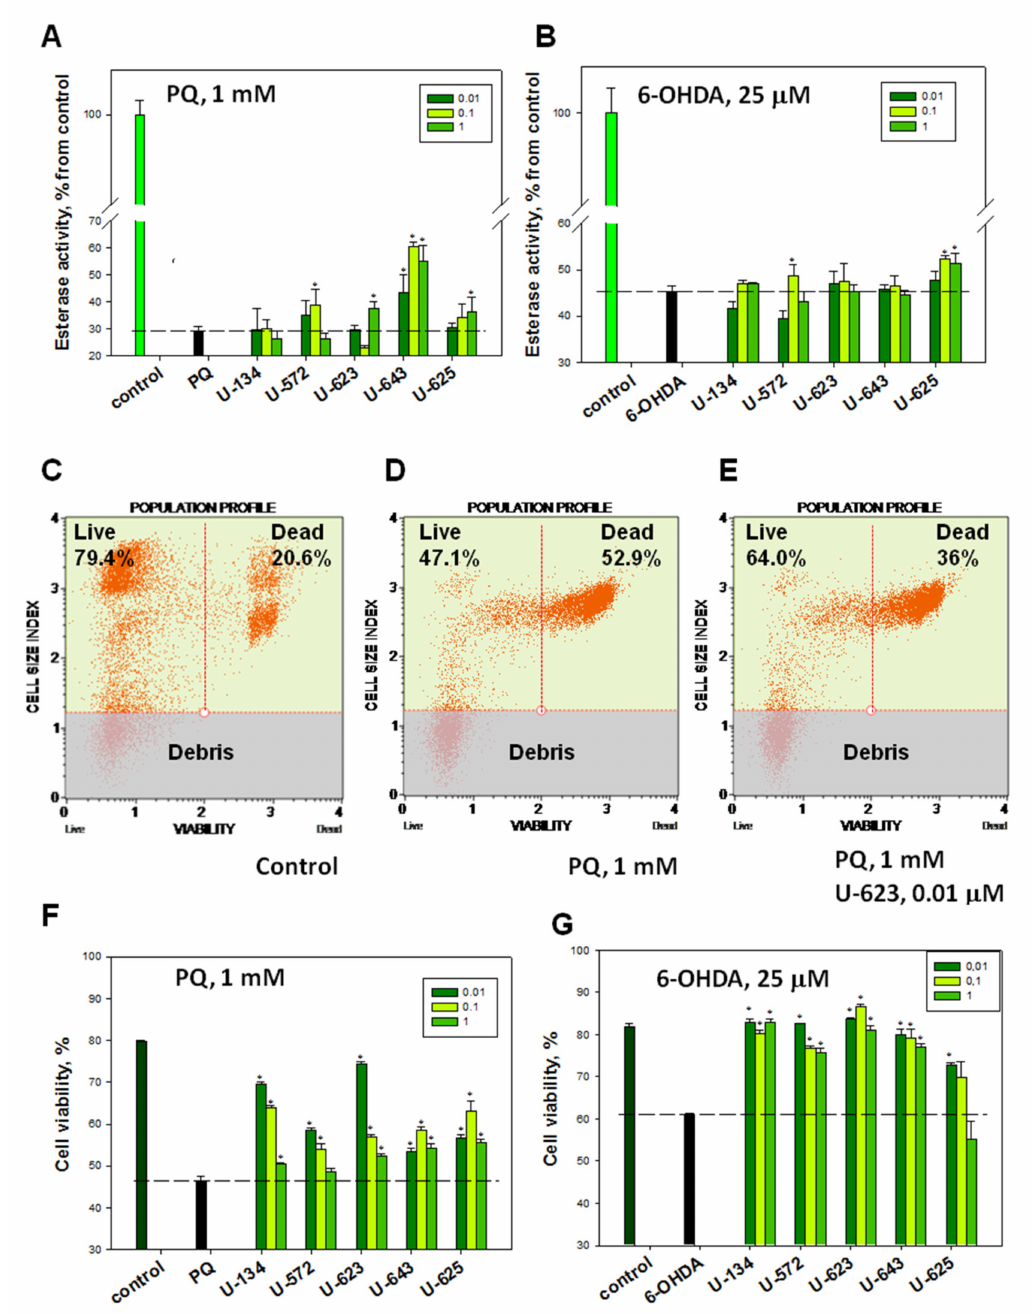
Figure 2. 1,4-NQs protect Neuro-2a cells against neurotoxicity induced by PQ and 6-OHDA. ( A , B ) determination of nonspecific esterase activity in cells incubated with PQ (1.0 mM, A ) or 6-OHDA (25.0 µ M, B ) using a FDA fluorescent probe and spectrofluorimetry. ( C – E ) count and viability assay. The figures show the percentage of live and dead cells determined using flow cytometry and PI staining: Control ( C ), PQ, 1.0 mM ( D ); PQ, 1.0 mM, and U-623 , 0.01 µ M ( E ). ( F , G ) determination of the viability of cells incubated with PQ ( F ) or 6-OHDA ( G ) using a PI fluorescent probe and fluorescent flow cytometry. Concentrations of 1,4-NQs in the culture medium were 0.01, 0.1, or 1.0 µ M. Data are presented as m ± se ( n = 3). * p < 0.05 compared to cells exposed to PQ or 6-OHDA